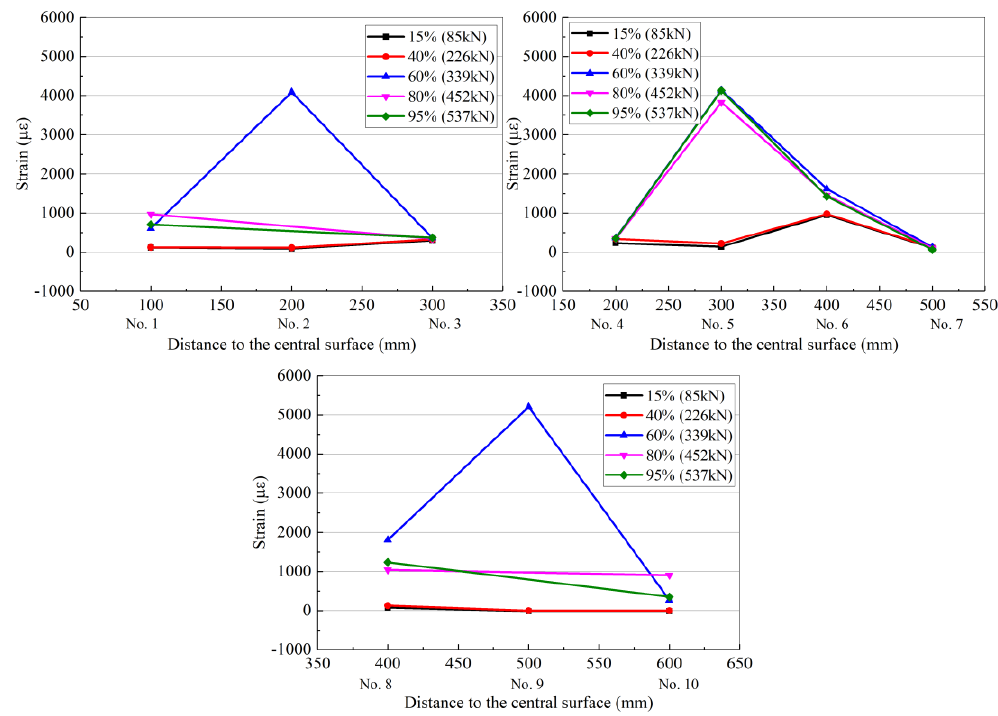
Figure 12. Strain distribution of flax fiber sheet for the RC-FRP1.